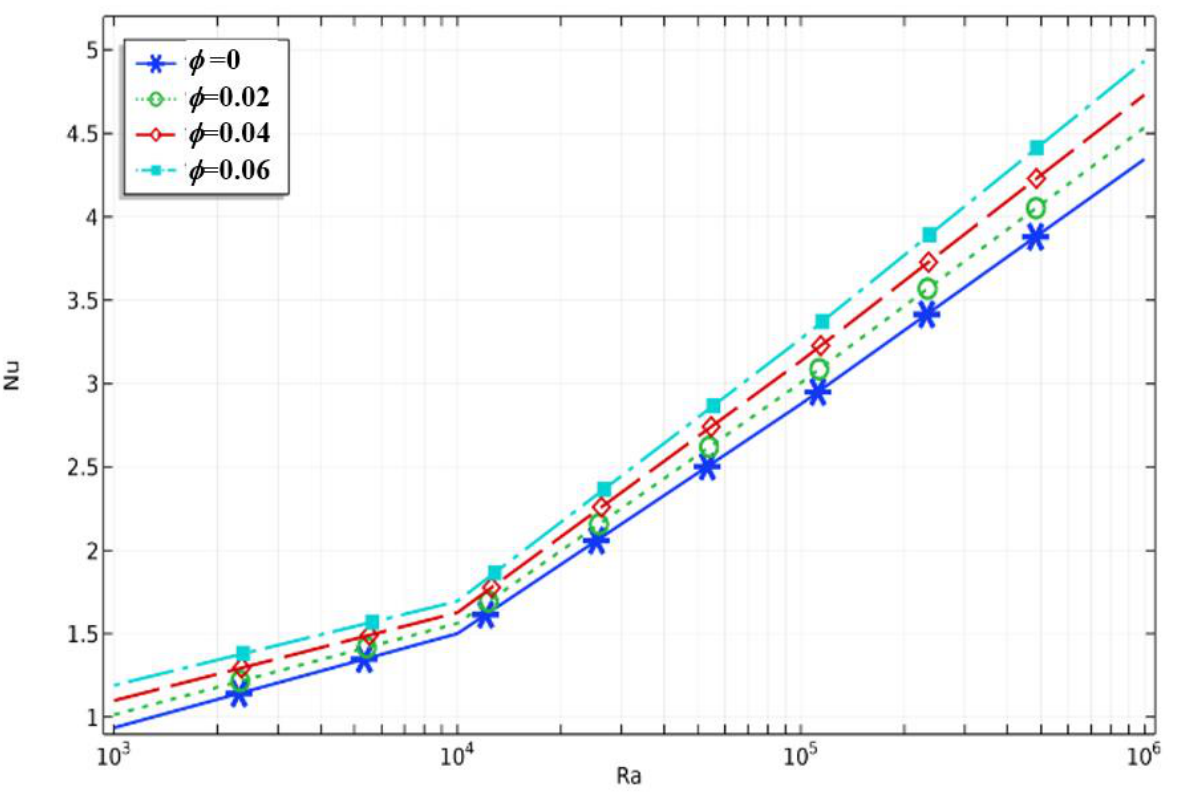
Figure 6. Average Nusselt number graph for various Rayleigh number and solid volume fraction at Kr = 1 and Φ = 90 .